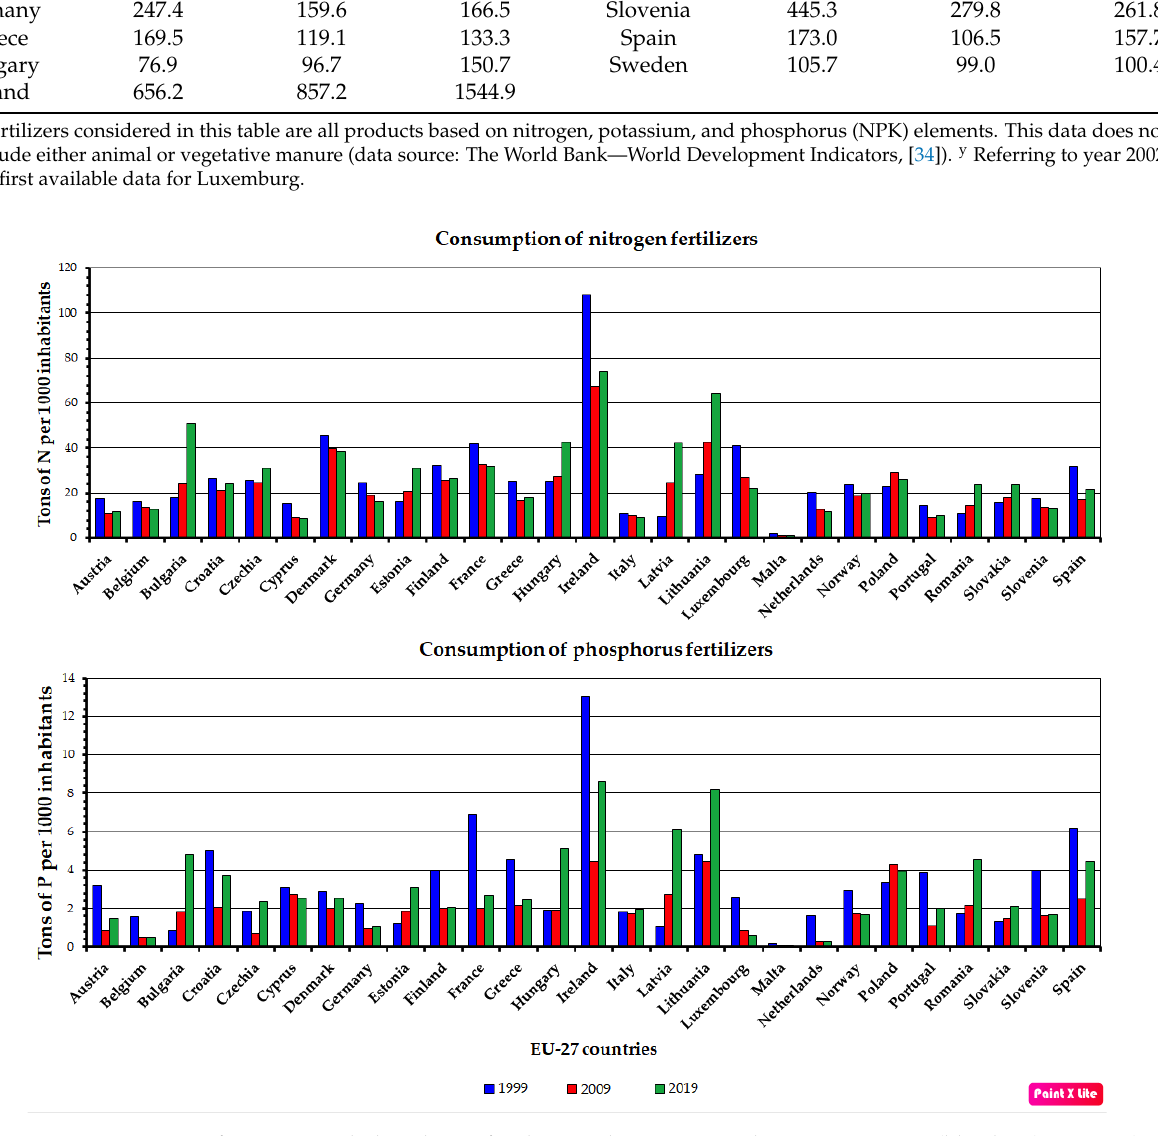
Figure 1. Consumption of nitrogen and phosphorus fertilizer in the EU-27 members states in 1999 (blue bars), in 2009 (red bars), and in 2019 (green bars). Tons of N-based fertilizers expressed as tons of N consumed by 1000 inhabitants in the upper graph; tons of P-based fertilizers expressed as tons of P consumed by 1000 inhabitants in the lower graph. Data source: EUROSTAT (Datasets: “Consumption of inorganic fertilizers” [AEI_FM_USEFERT] and “Population on 1 January by age and sex”